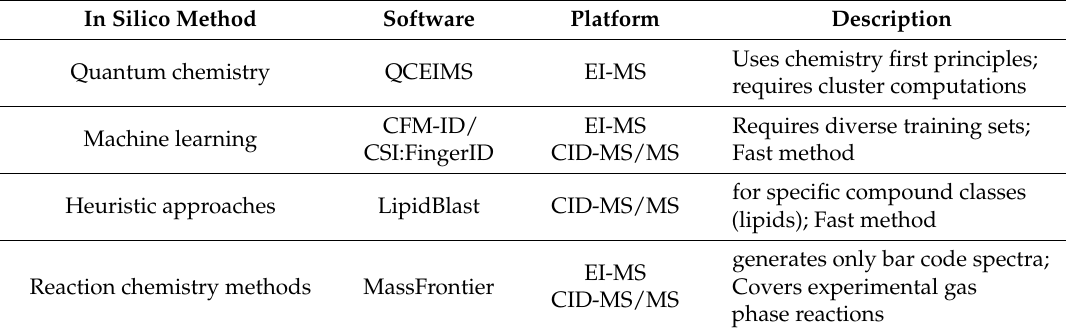
Table 4. Overview of methods for in silico generation of mass spectra, including commercially or freely available algorithms. Additional tools are referenced in text. In Silico Method Software Platform Description Quantum chemistry QCEIMS EI-MS